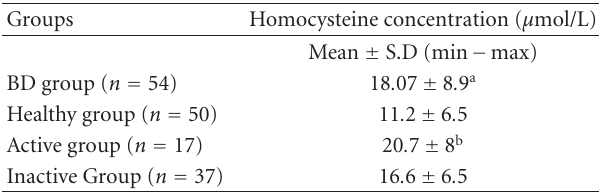
Table 1: Cumulative clinical characteristics of patients with Behc¸et’s disease.